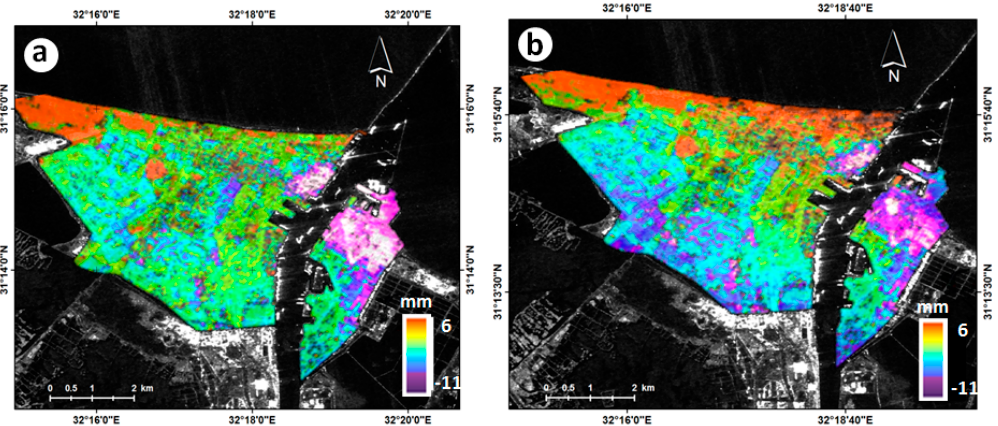
Figure 8. ( a ) Unwrapped interferogram before the refinement and re-flattening steps (master; 14 November 2008 and slave; 12 November 2007); and ( b ) well-unwrapped interferogram after the refinement and re-flattening